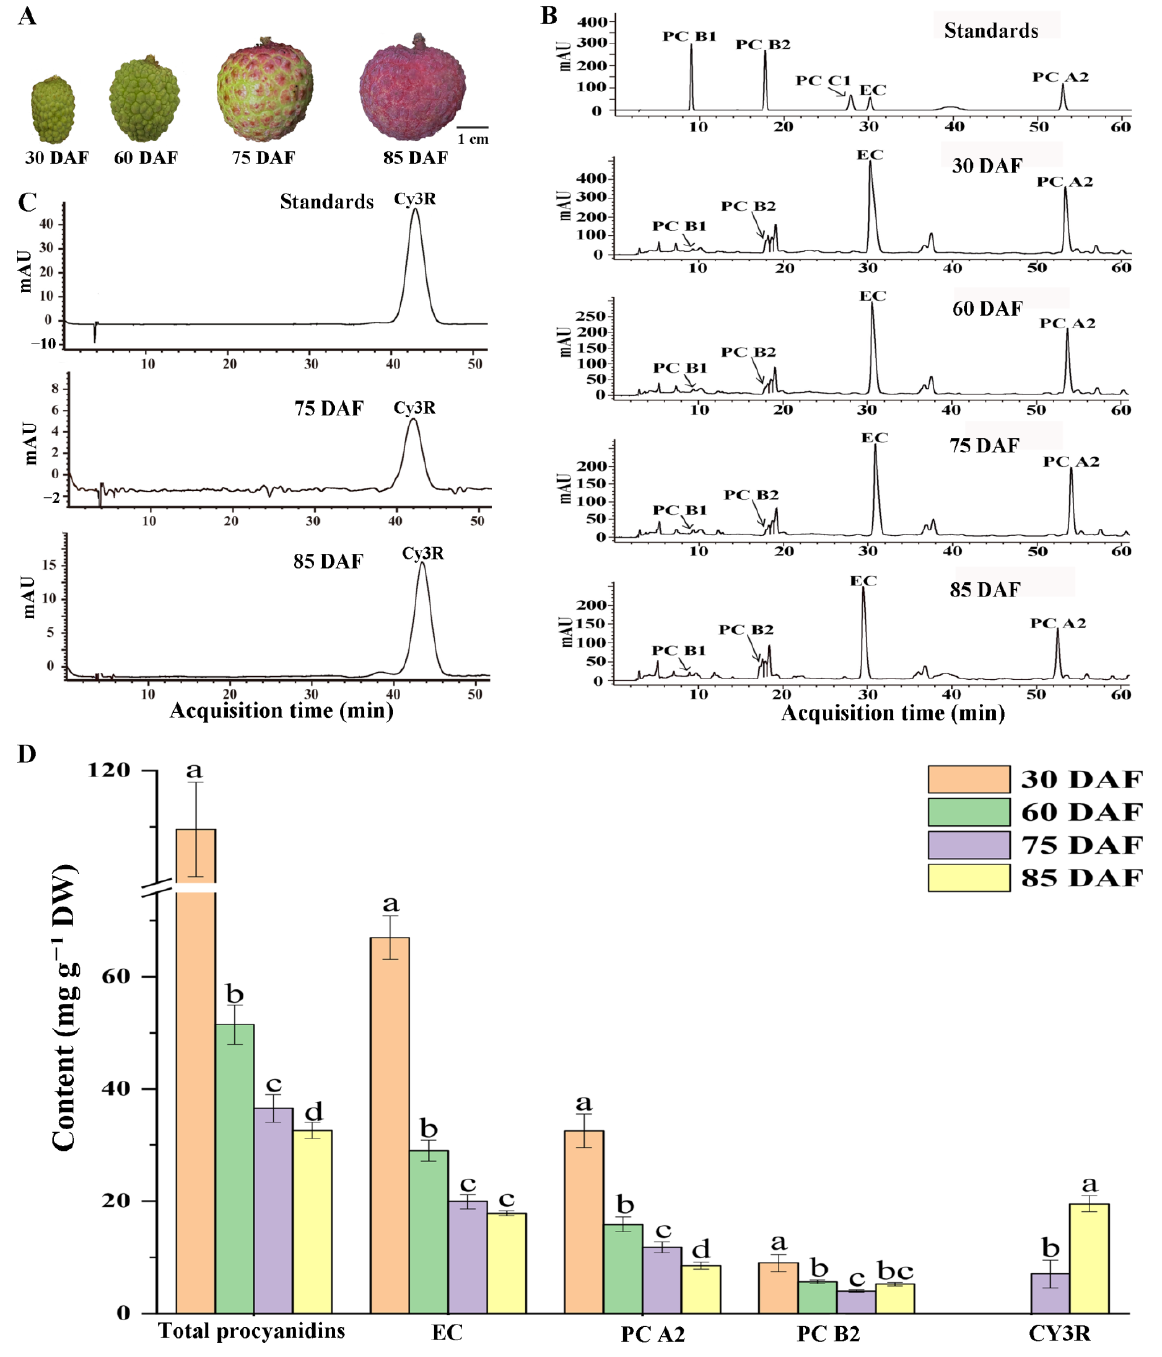
Figure 1. Proanthocyanidin and anthocyanin content of litchi pericarp. ( A ) Images of litchi fruit during development at 30, 60, 75, and 85 DAF, representing the young, growing, color-break, and mature stages, respectively. ( B ) Mixed standard HPLC chromatograms of a variety of (epi)catechin/PCs and the soluble PA extract of litchi pericarp samples at the four stages as described in ( A ) with the absorbance at 280 nm. ( C ) Standard HPLC chromatograms of Cy3R and the pericarp extracts (75 and 85 DAF) with the absorbance at 510 nm. ( D ) Epicatechin/PC and anthocyanin content of litchi pericarp at the four developmental stages. Values are the means of three biological repeats. Error bars indicate ± SE. Statistical significance was determined using t-tests , and significant differences ( p < 0.05) among the samples at different developmental stages were classified with the letters a, b, c, or d. EC: ( − )-epicatechin; CT: (+)-catechin; PC: procyanidin; and Cy3R: